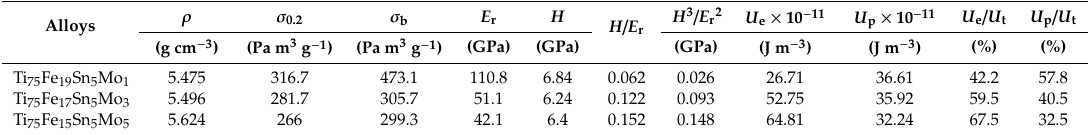
Table 3. Density ( ρ ) and mechanical properties of Ti–Fe–Sn–Mo alloys. Such as specified yield strength ( σ 0.2 / ρ ), specific maximum strength ( σ b / ρ ), harden ( H ), reduced elastic modulus ( E r ), H / E r , H 3 / E r2 , U e , U p , U e / U t , and U p / U t (where U p , U e , and U t denote the plastic, elastic, and total indentation energies,